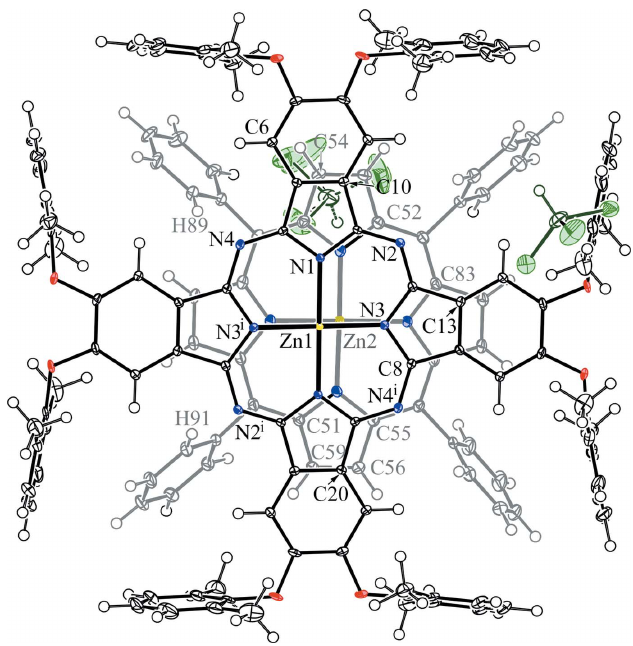
Figure 1 The expanded asymmetric unit of the title supramolecule in a view from the ZnPc macrocycle, with displacement ellipsoids drawn at the 50% probability level. Atom labels of ZnPc and ZnTPP are black and grey, respectively. ZnTPP and chloroform molecules generated by inversion operation through the origin at Zn1 have been omitted for clarity [symmetry code: (i) (cid:4) x + 1, (cid:4) y + 1, (cid:4) z +